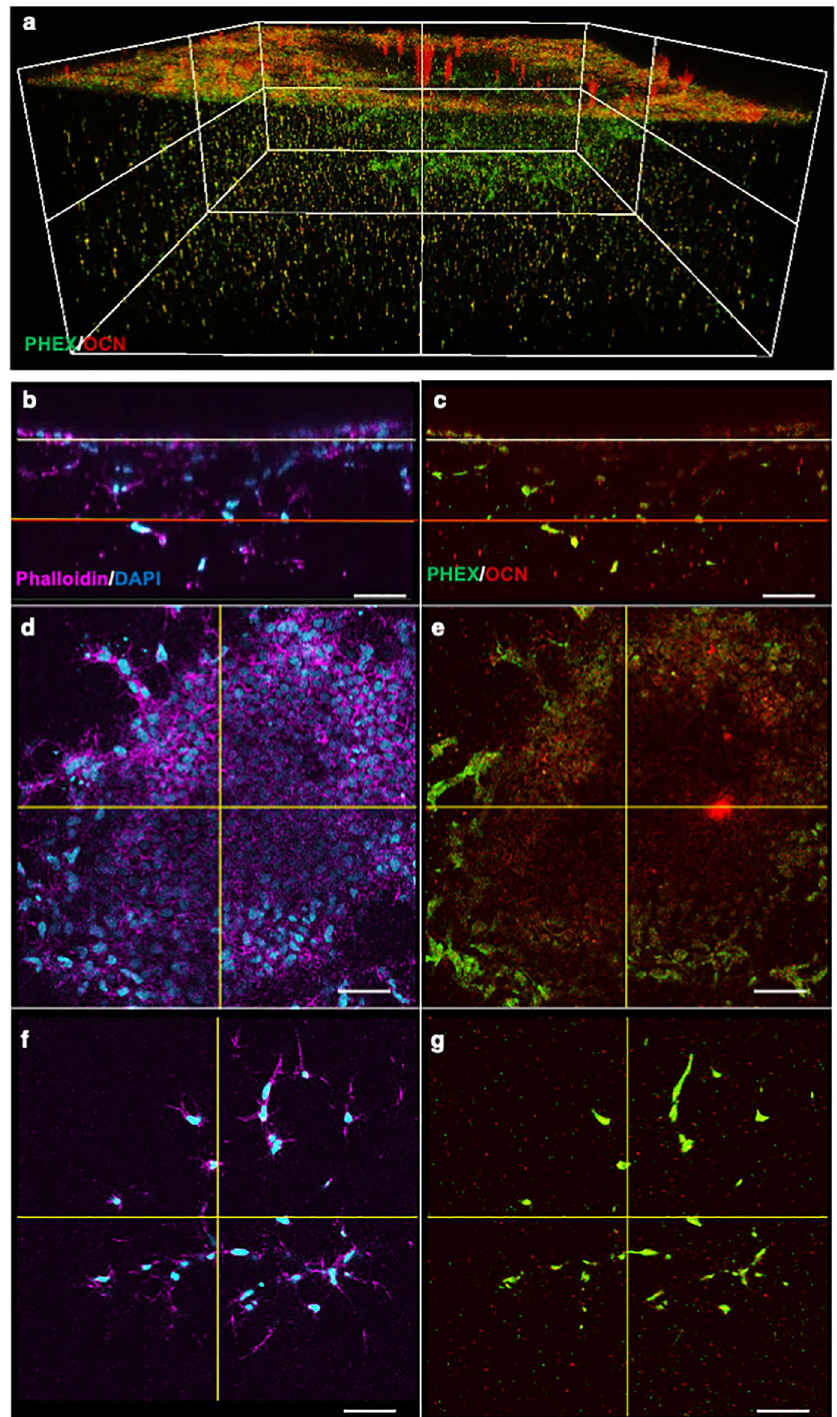
Figure 3. Expression of stage-related markers in 3D culture. ( a ) Reconstructed 3D view of confocal images at day 14. Collagen gels with induced cells (414C2) were stained with antibodies for PHEX (green) and OCN (red), and immunofluorescence images obtained by confocal analysis were reconstructed to build 3D images. ( b – g ) Immunofluorescence analysis by confocal imaging. Collagen gel with induced cells at day 14 were stained with Phalloidin (magenda) and DAPI (skyblue) ( b , d , f ) or antibodies for PHEX (green) and OCN (red) ( c , e , g ). Horizontal images were analyzed at surface ( d , e ) and deep ( f , g ) levels indicated by the white and red lines in ( b ) and ( c ), respectively. Scale bars = 50